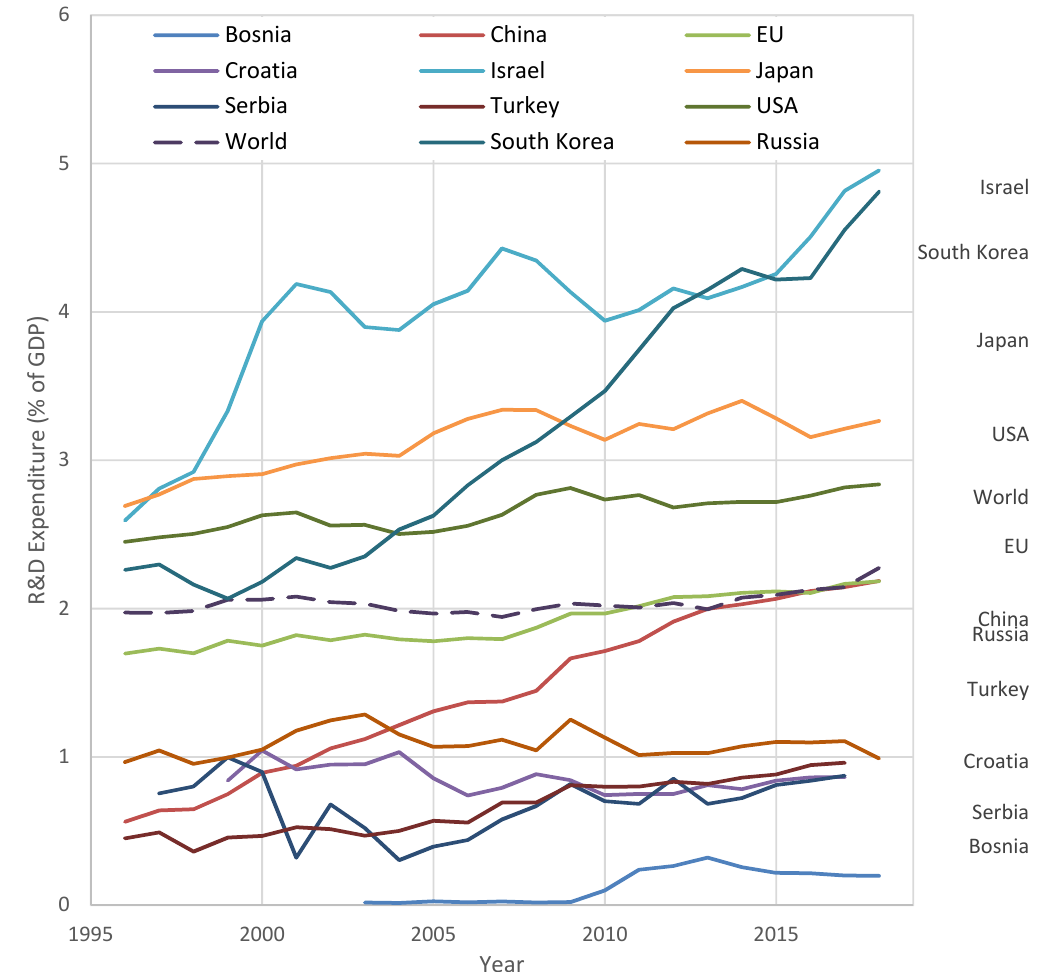
Figure 4. R&D Expenditure in Bosnia and for selected countries